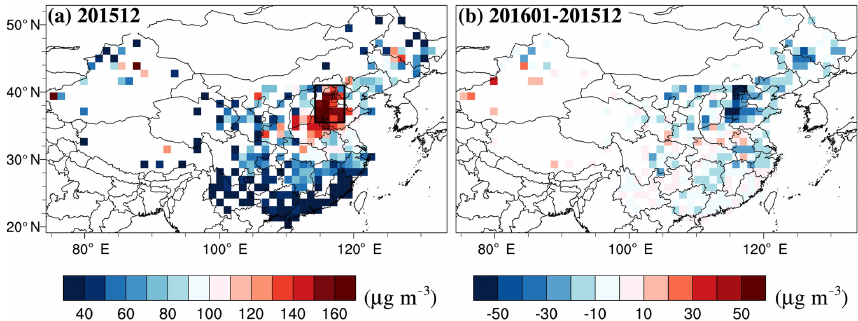
Figure 1. Monthly mean PM 2 . 5 concentration in December 2015 (a) , and the difference (b) between the anomaly of January 2016 (relative to January from 2015 to 2017) and December 2015 (relative to December from 2014 to 2016). The black box in (a) indicates the area of the NCP.